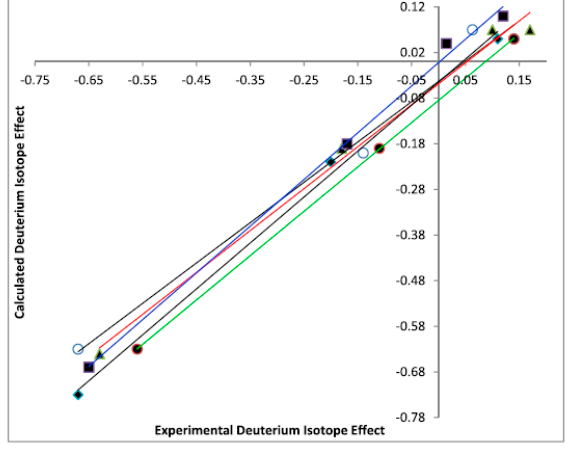
Figure 29. Plot of calculated vs. experimental deuterium isotope effects on 13 C chemical shifts. The